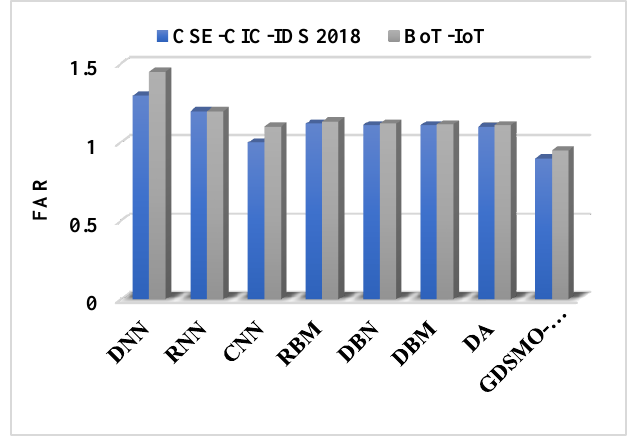
Figure 19. FAR of existing and proposed deep learning mechanisms for both the CSE-CIC-IDS 2018 and BoT-IoT datasets.